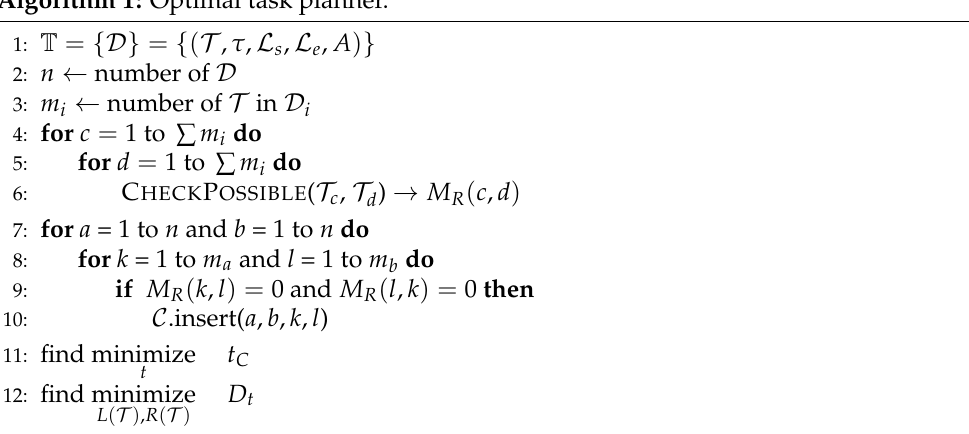
Algorithm 1: Optimal task